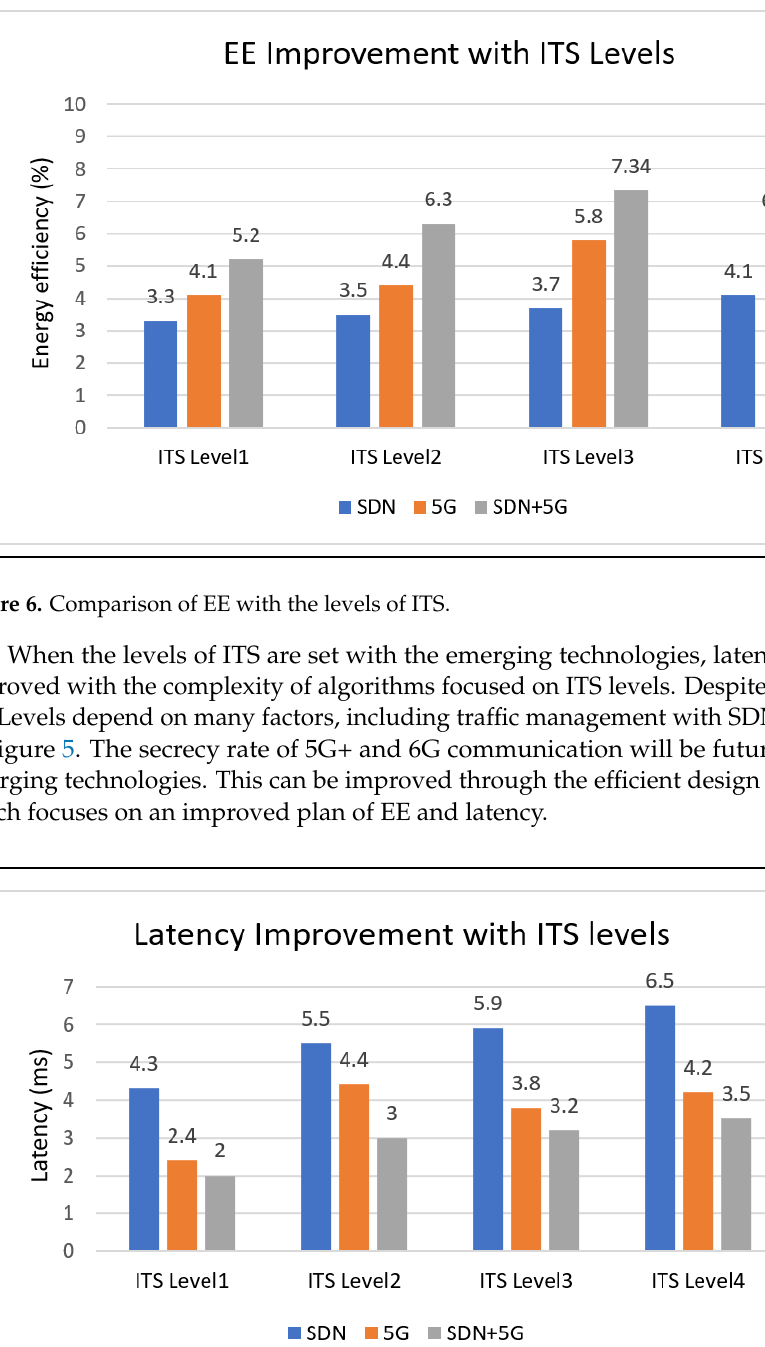
Figure 7. Comparison of latency with different levels of ITS.